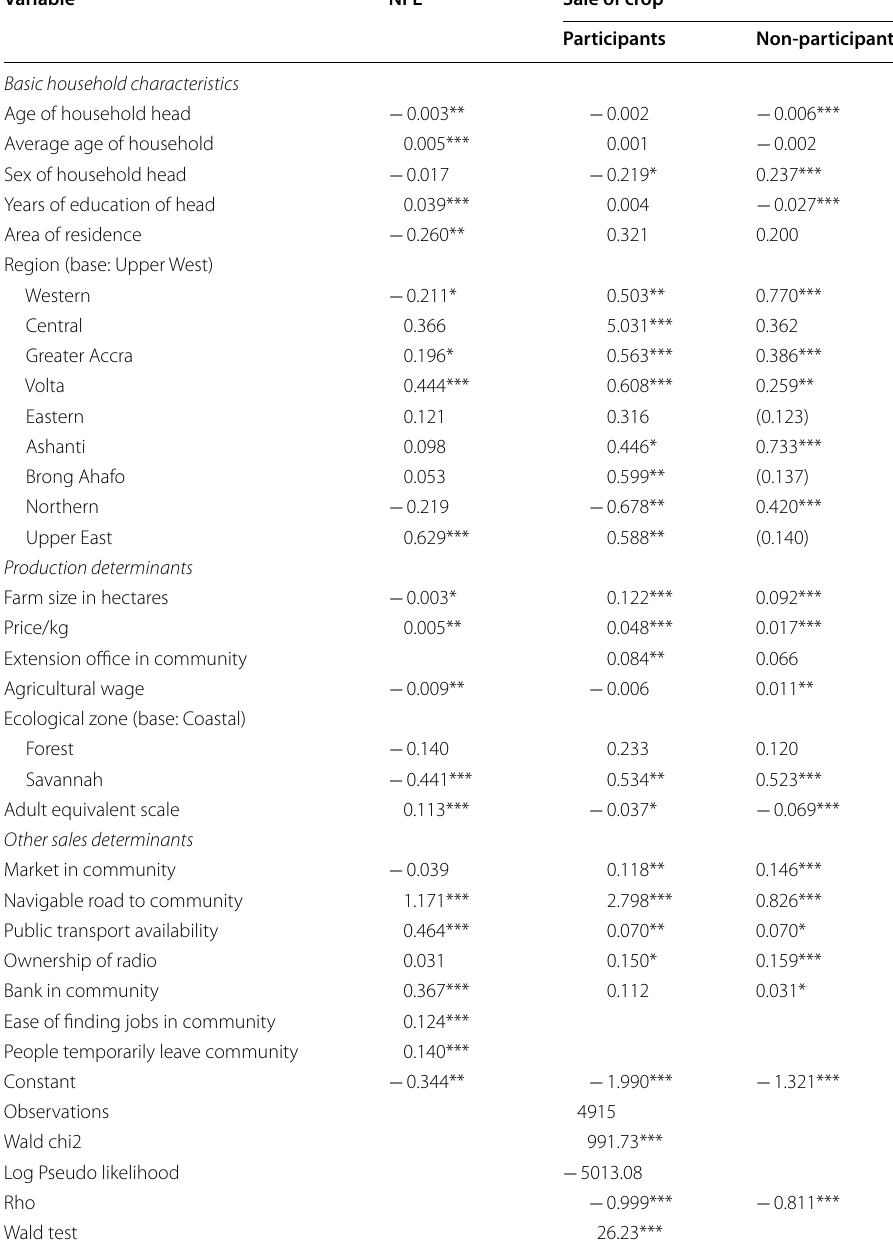
Table 3 Determinants of nonfarm activity and sale of